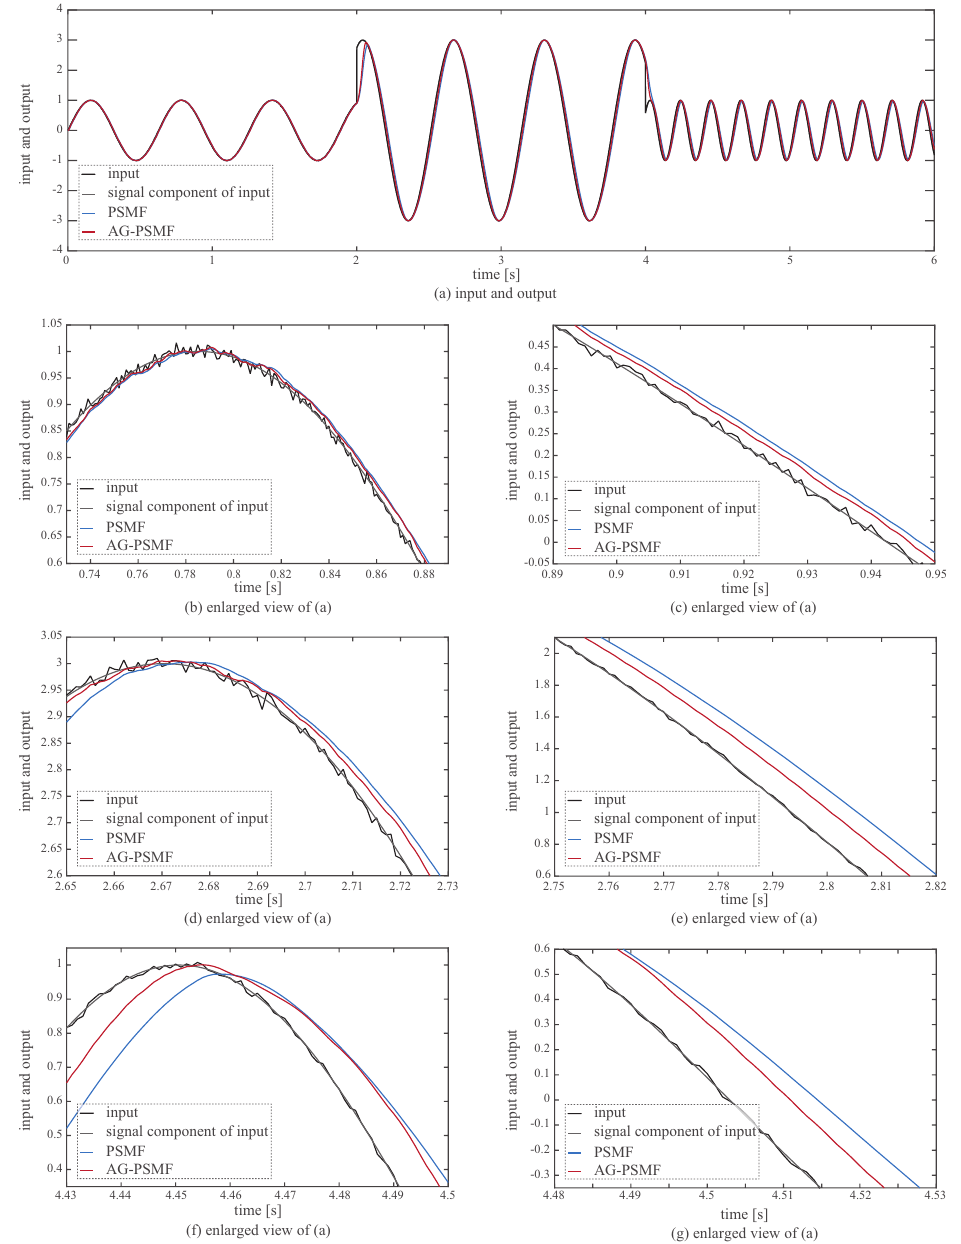
Figure 9. ( a – g ) Comparison between the outputs of AG-PSMF and PSMF for a sinusoidal input that is corrupted by white Gaussian noise. (AG-PSMF: F = 1000, H = 3, N max = 5, N c = 4, R = 0.00075; PSMF: F = 1000, H = 3; T = 0.001